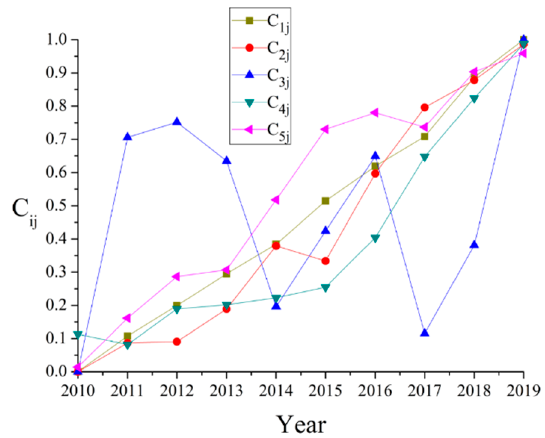
Figure 6. Evaluation results of the D–P–S–I–R subsystem.